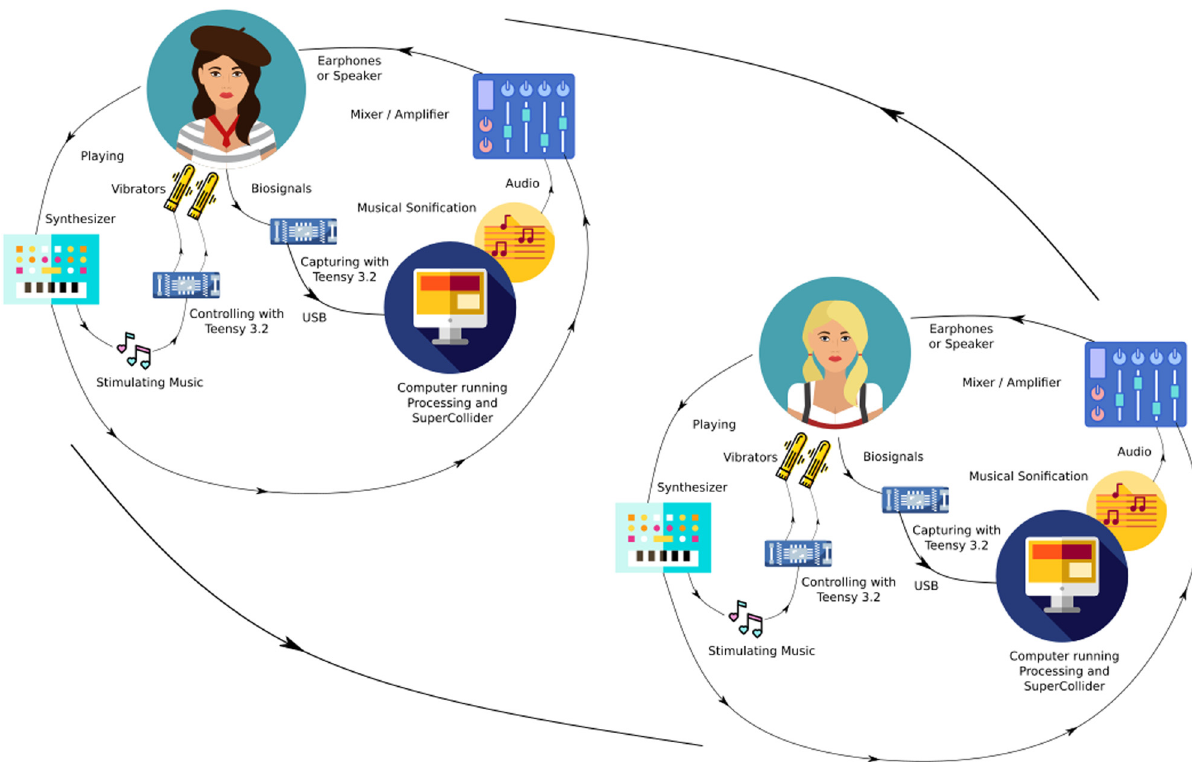
Figure 28: PLAY ME in a two - user scenario.